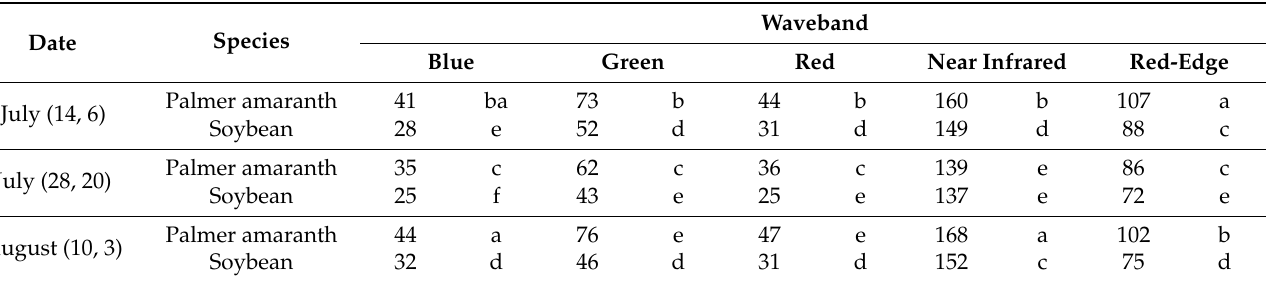
Table 2. Spectral reflectance values of Palmer amaranth and soybean across dates and fields from aerial imagery collected from an altitude of 15 m at Rocky Mount, NC in